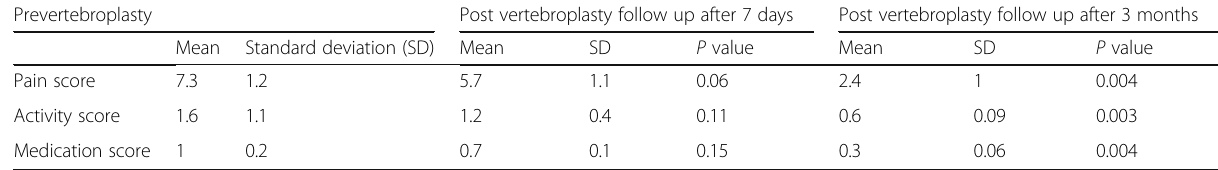
Table 5 Pain score, activity score and medication score after 7 days and 3 months post procedure Prevertebroplasty